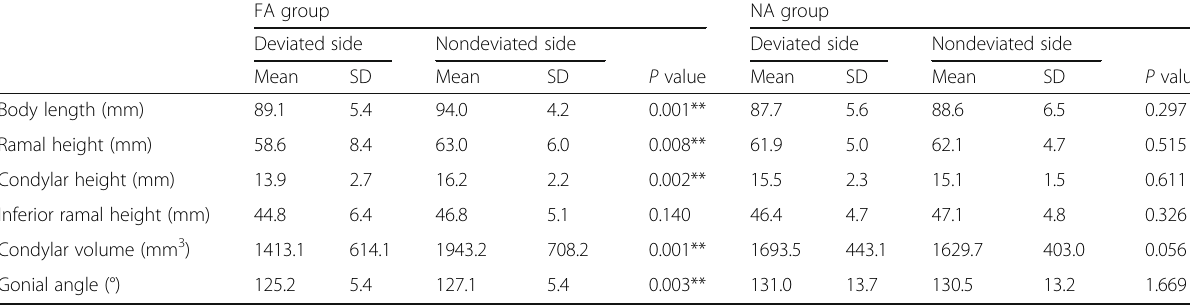
Table 3 Bilateral comparison of the mandibular components in the FA and NA groups FA group